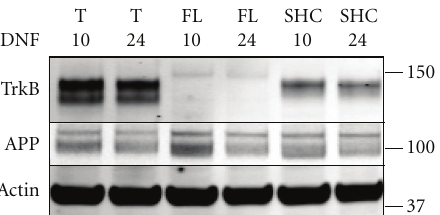
Figure 6: Short-term or long-term BDNF treatment of TrkB isoforms transfected cells. APP full-length (FL) levels are increased by a 10 minutes BDNF treatment of TrkB FL transfected cells while a 24 hours treatment shows lower APP FL levels. TrkB T and TrkB SHC transfected cells are not significantly a ff ected by short term or long-term BDNF